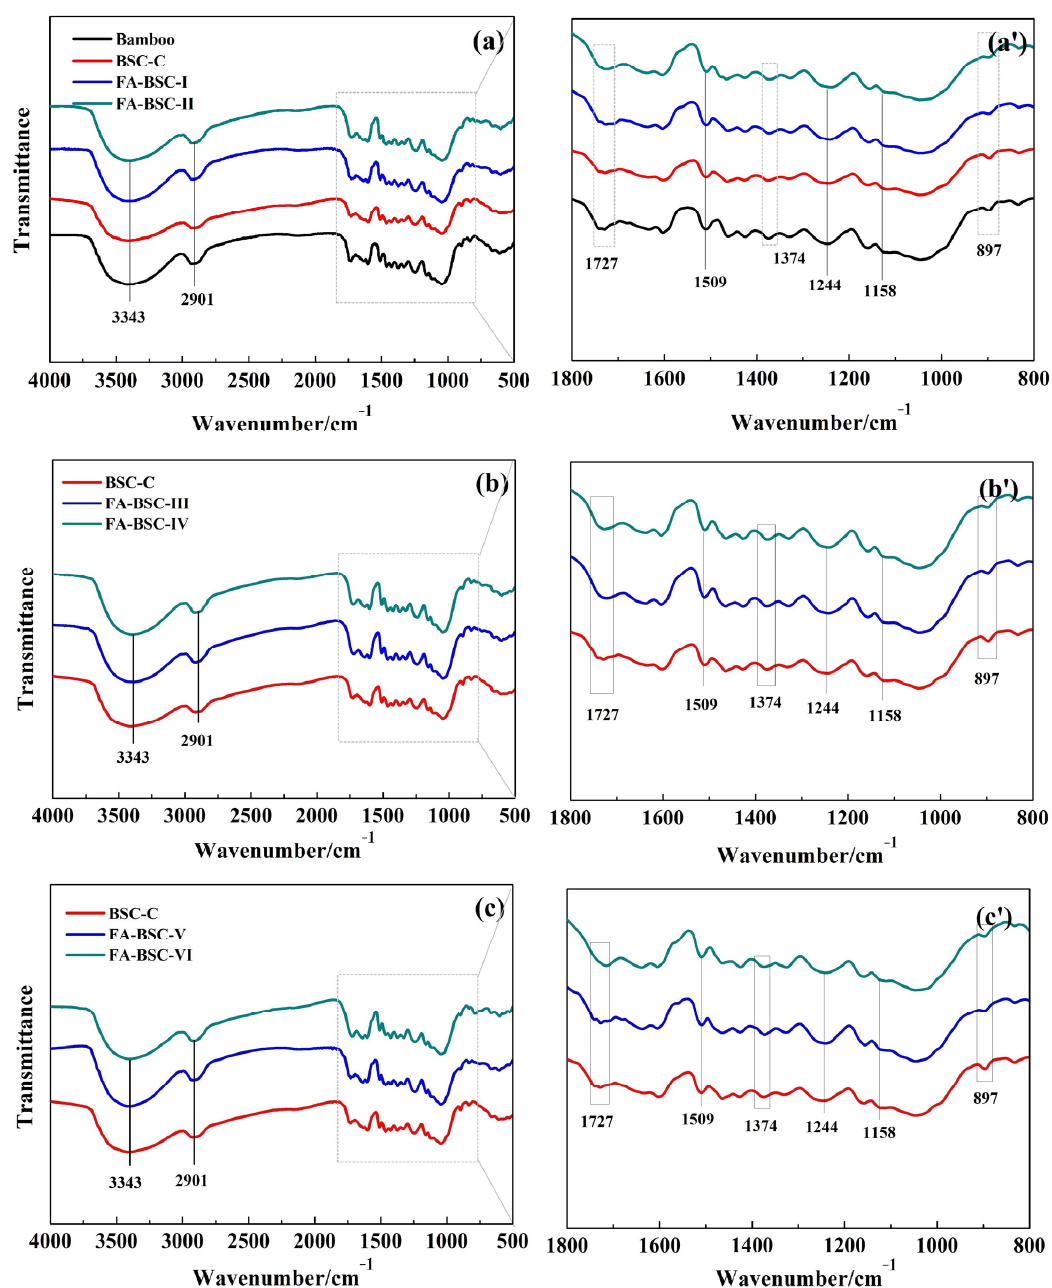
Figure 4. FTIR spectra of bamboo, untreated BSCs, and furfurylated BSCs. Peak assignment: 3343 cm − 1 assigned to O-H stretching vibrations (cellulose), 2901 cm − 1 assigned to alkyl group (-CH 2 ), 1727 cm − 1 a tt ributed to the stretching of acetyl and carboxyl acid (hemicellulose), 1509 cm − 1 assigned to the aromatic skeletal vibrations in lignin, 1374 cm − 1 assigned to the C-H deformation bonds (cellu- lose and hemicellulose), 1244 cm − 1 assigned to the C-O stretching of the guaiacyl ring in lignin, 1158 cm − 1 assigned to the C-O-C bond, 897 cm − 1 assigned to the structural contribution of cellulose and hemicellulose. ( a’ , b’ , c’ ) was the fi ngerprint region in the range of 800-1800 cm − 1 of ( a , b , c ), respec- tively.